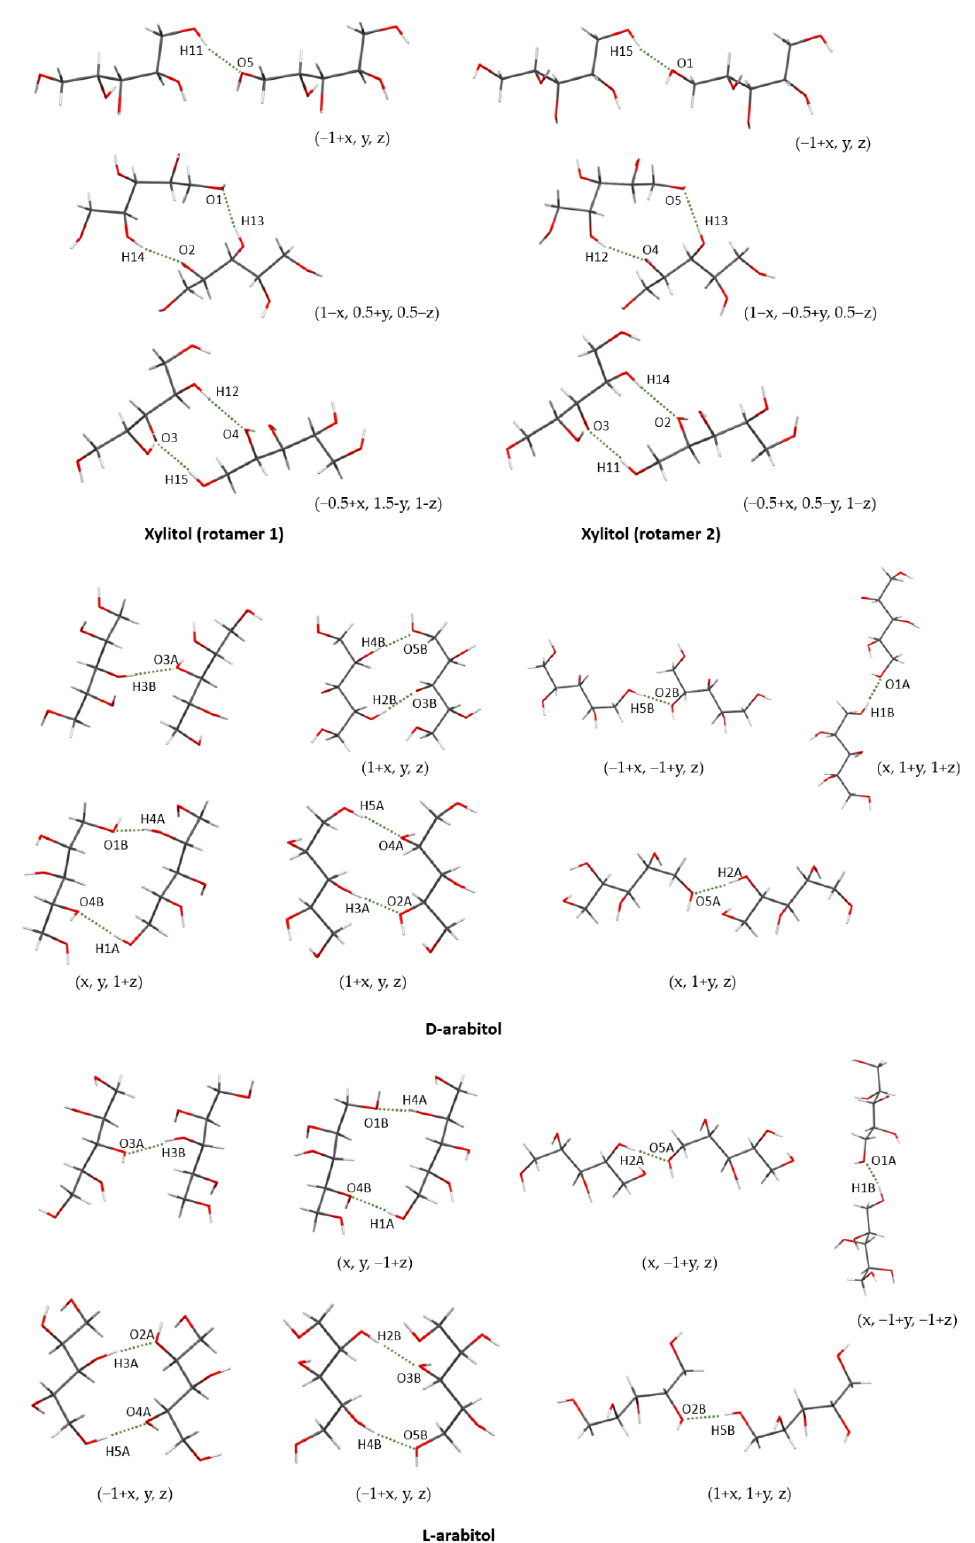
Figure 11. Dimers of rotamers 1 and 2 of xylitol as well as L- and D-arabitol. For clarity, only interacting atoms are assigned. Symmetry operations are given in parenthesis. Dimers O3A…H3B are formed within asymmetric unit.